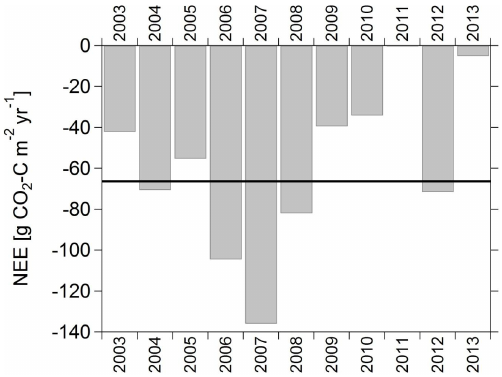
Figure 4. Annual NEE for 2003–2013 (no data for 2011 due to instrument failure during the growing season); the horizontal line is the mean NEE for the study period.